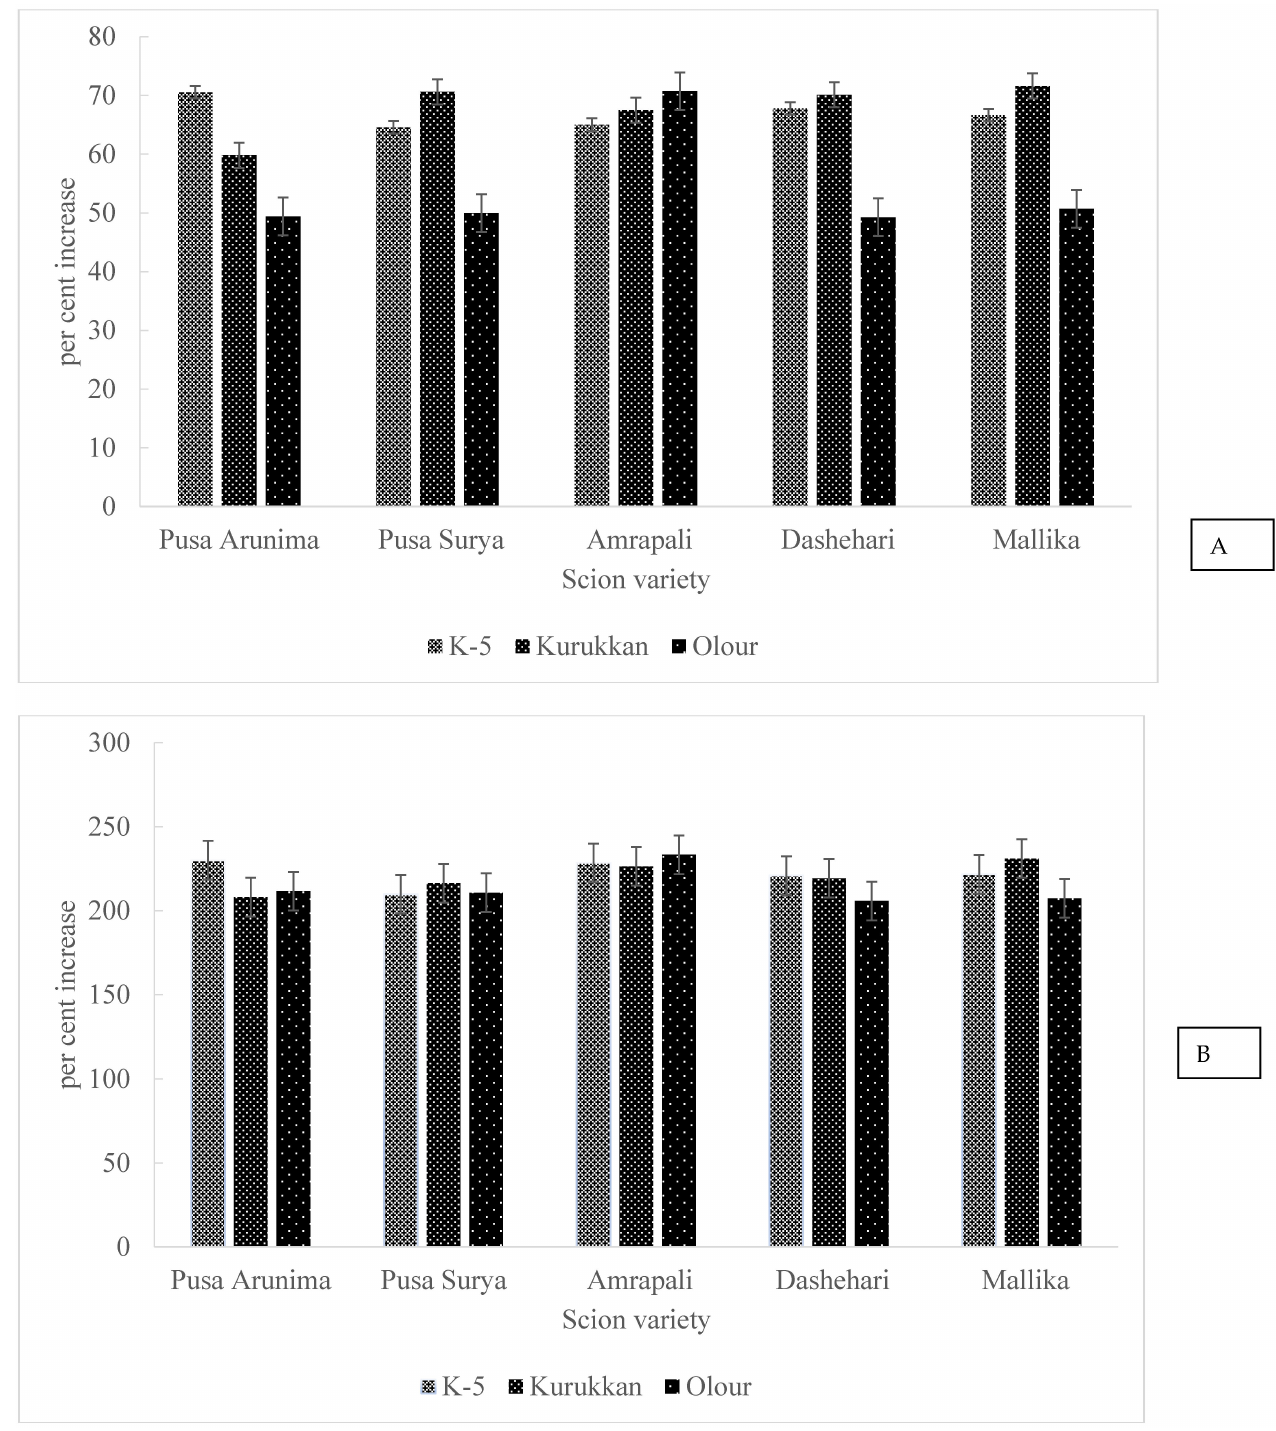
Figure 2. Increase in respiration rate on the 3rd ( A ) and 6th day ( B ) of storage compared to the normal ripening (0 day) as affected by scion/rootstock combinations in mango. Vertical bar indicates mean values of three samples ± standard error (SE). The LSD ( p ≤ 0.05) for 3rd day storage: variety; 7.85, rootstock; 6.08, and variety × rootstock; 13.6, for 6th day storage, variety; 31.32, rootstock; 24.26, and variety × rootstock;